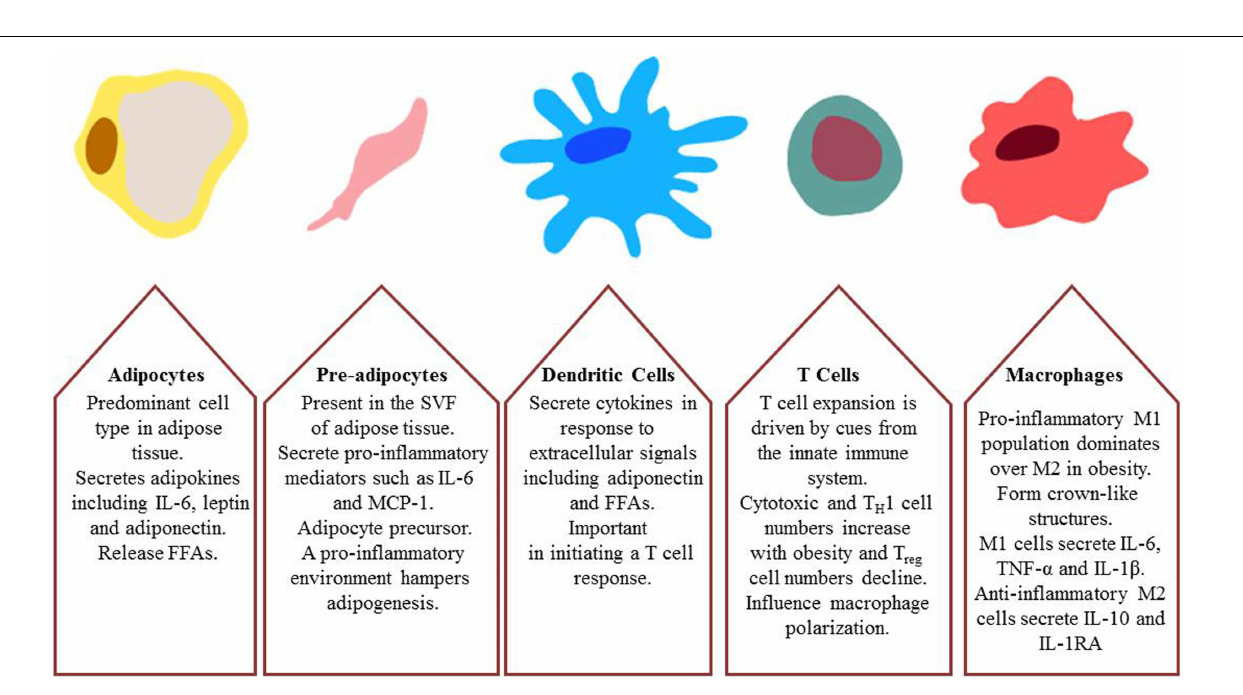
FIGURE 3 | Major cell types involved in obesity-induced inflammation and insulin resistance; adipocytes, pre-adipocytes, dendritic cells,T cells, and macrophages